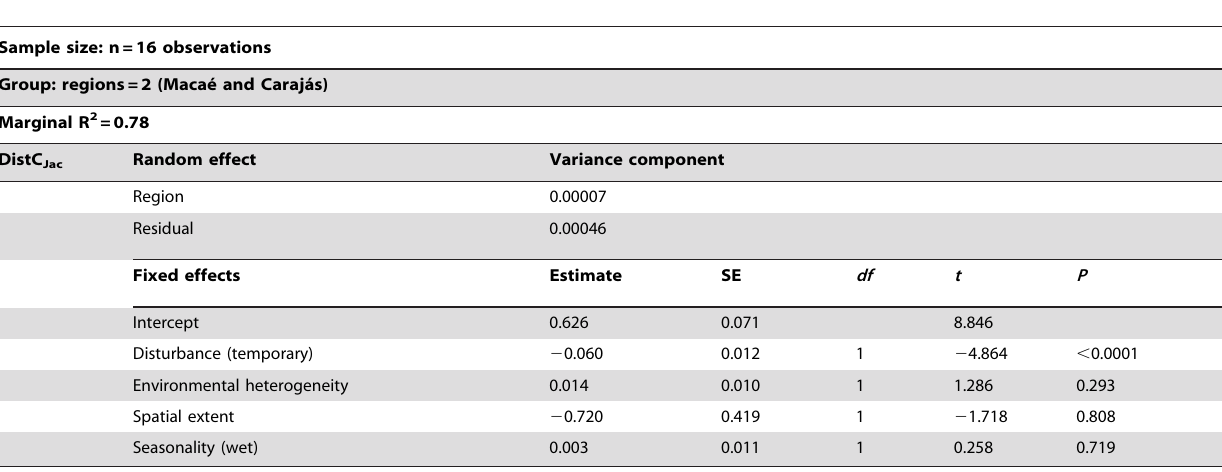
Table 2. Summary of the linear mixed-effects model of zooplankton beta diversity measured as the mean1-Jaccard distance to group (DistC Jac ) centroid for disturbance data (permanent and temporary aquatic systems from Macae´ and Caraja´s).